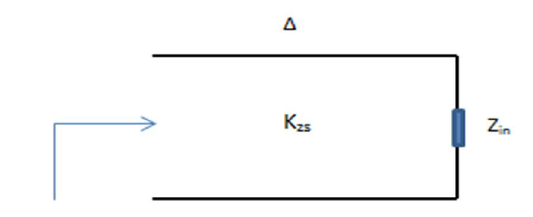
Figure 2: Transmission line equivalent representation of a horizontal